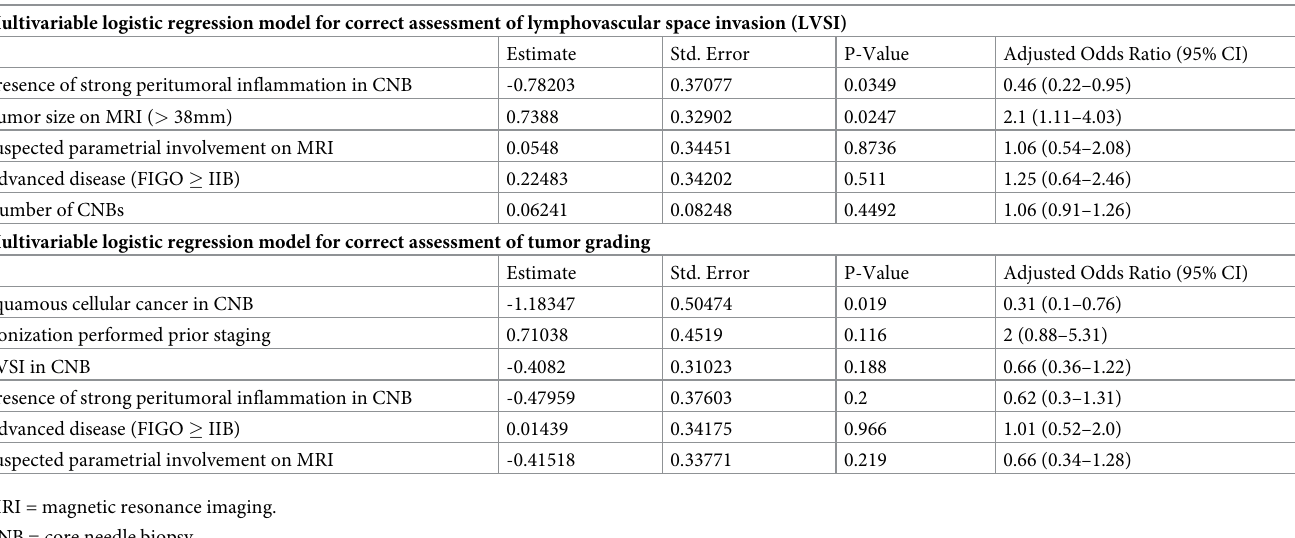
Table 2. Multivariable logistic regression model for correct assessment of lymphovascular space invasion (LVSI) and tumor